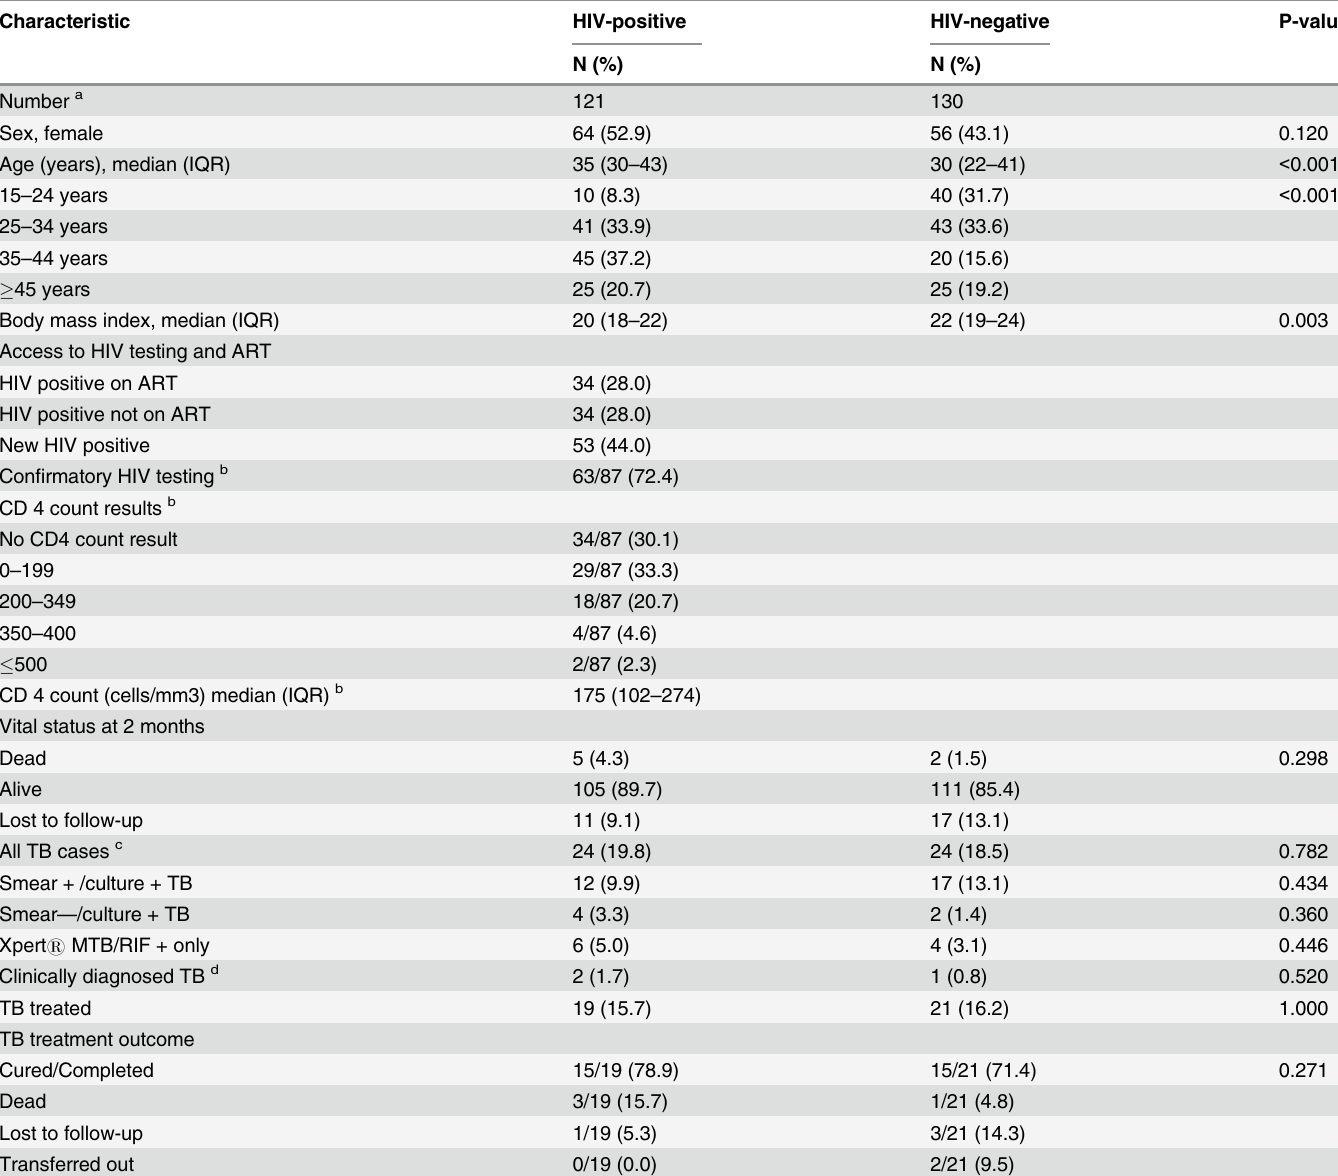
Table 1. Baseline characteristics and tuberculosis and HIV diagnostic